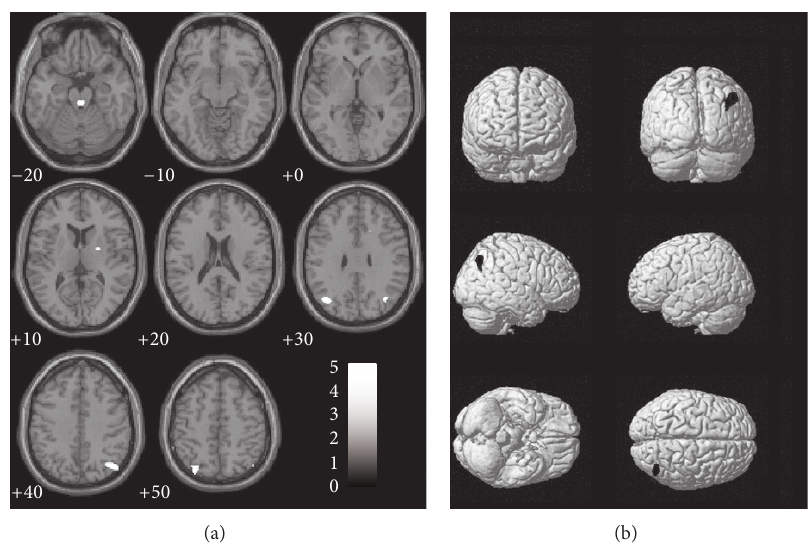
Figure 2: Surface rendering (a) and sagittal sections (b) showing the grey matter reduction in PD patients with respect to controls at retest. Numbers below each sagittal slice represent the 𝑥 coordinate in MNI space. Clusters are superimposed on the MNI template implemented in SPM8 ( 𝑃 = 0.001 uncorrected; 𝑘 > 223